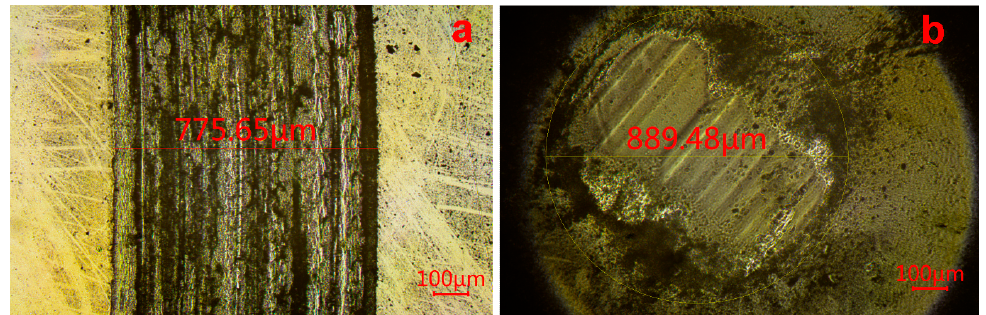
Figure 10. Images of wear scar of Si 3 N 4 ball/a-Si:H films at 600 °C: ( a ) a-Si:H; ( b ) ball.